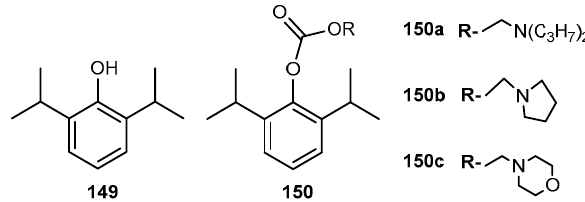
Figure 63. Chemical structure of amino acid derivatives of 149 [199].